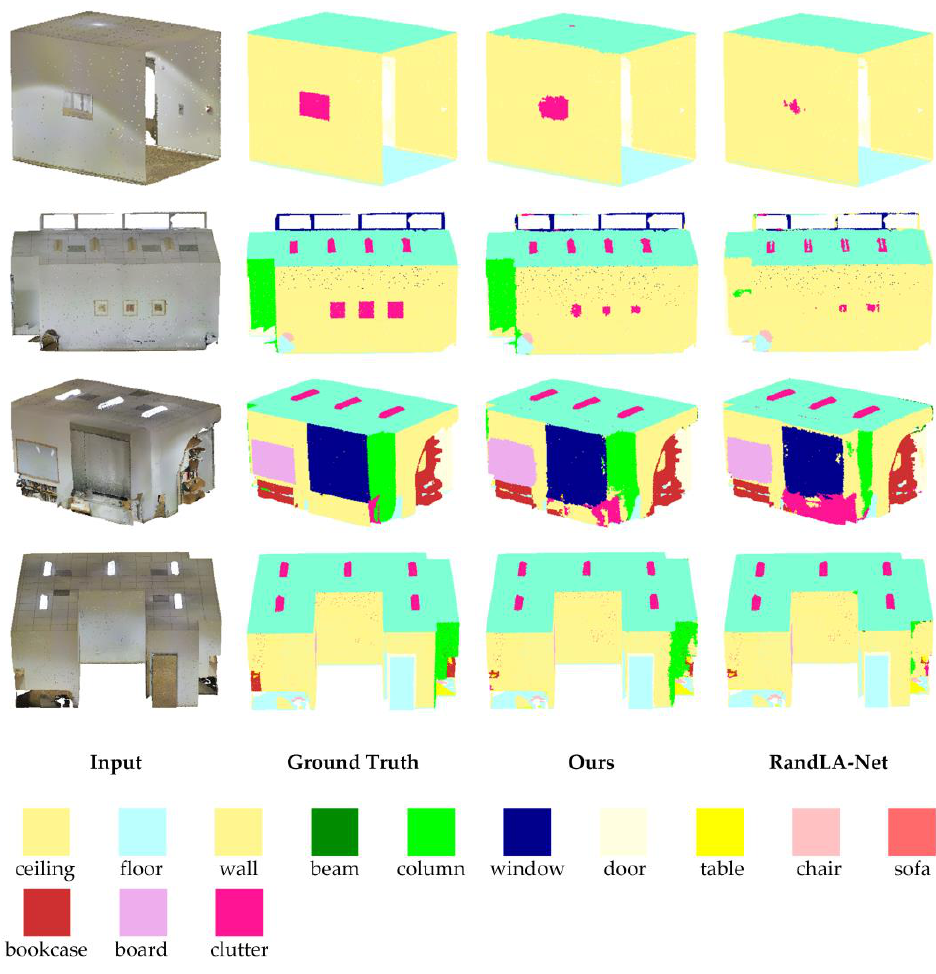
Figure 10. Visualization of semantic-segmentation results on S3DIS datasets area 5.